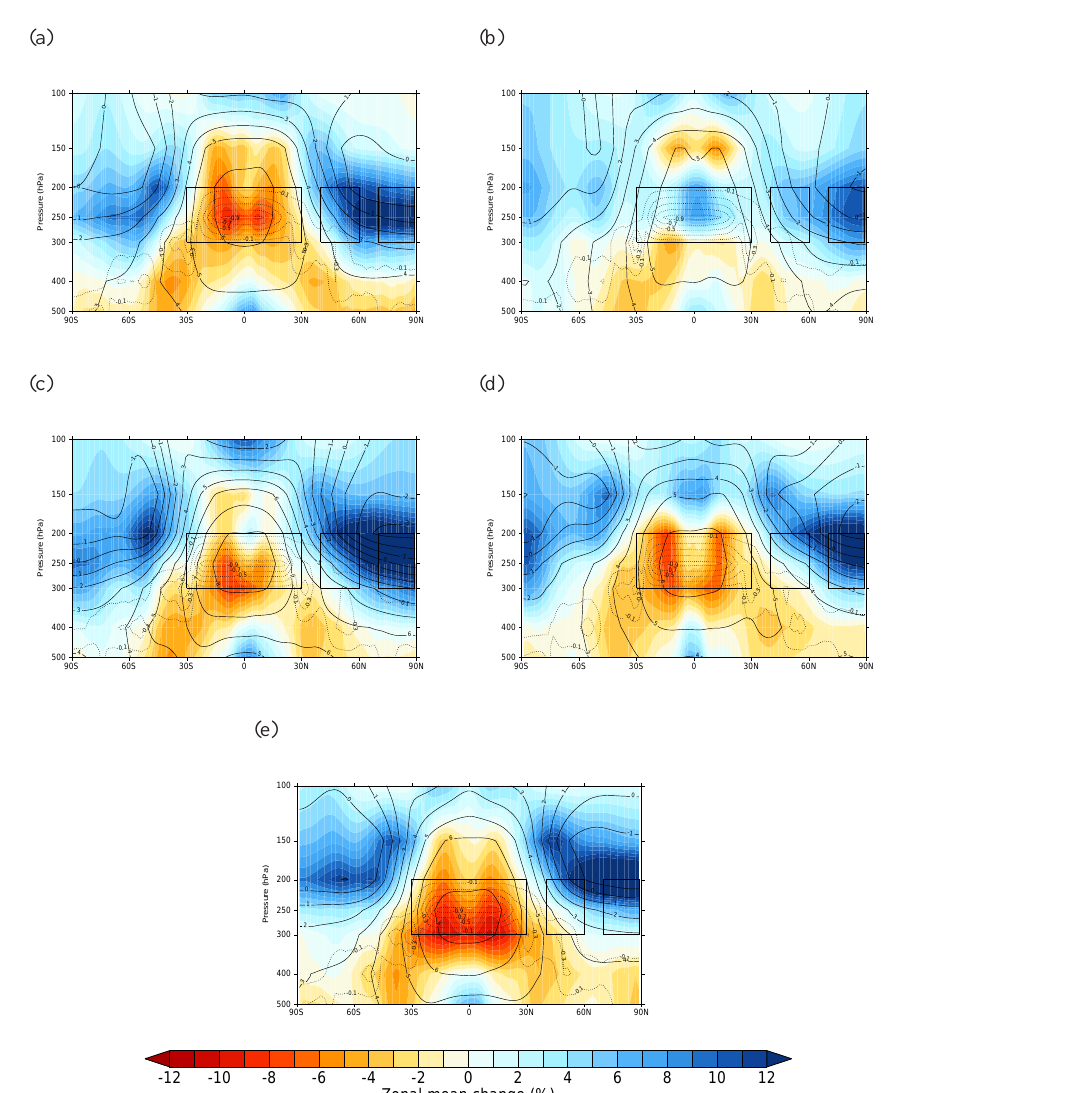
Figure 7. Zonal-mean change in annual-mean RHi (colours), temperature (solid black lines) and fraction of points below the 233K temper- ature threshold (dotted black lines) as a function of pressure for the CMIP5 models (a) EC-EARTH, (b) GFDL-ESM2G, (c) HadGEM2-CC, (d) MIROC5 and (e) MPI-ESM-MR. The changes are calculated using monthly-mean data, as the average over 2073–2099 (RCP8.5 sim- ulation) minus the average over 1979–2005 (historical simulation). The subregions of particular interest are highlighted by black boxes: the tropics, Northern Hemisphere mid-latitudes and Northern Hemisphere polar regions. The vertical range of these boxes is 200–300hPa, spanning the range of typical cruise altitudes for commercial